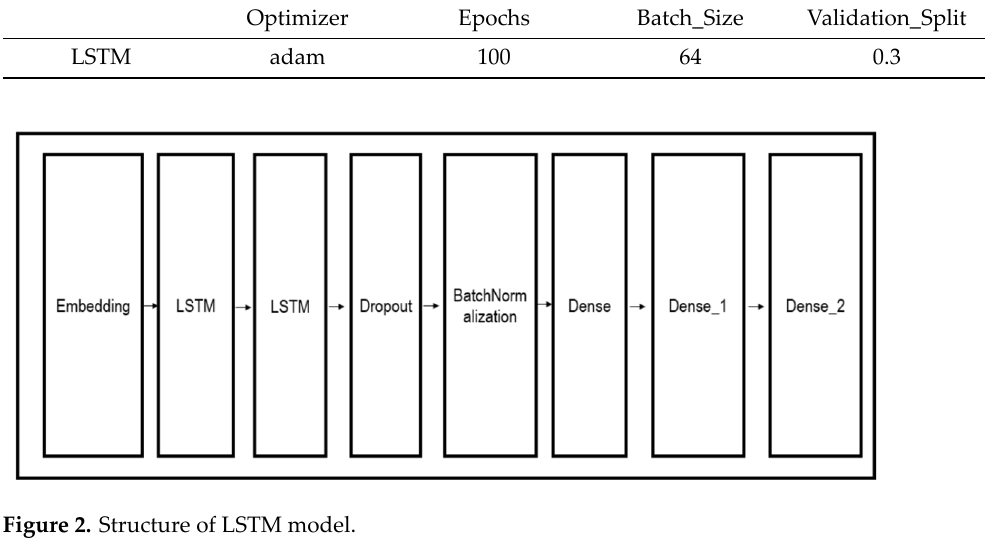
Figure 2. Structure of LSTM model.